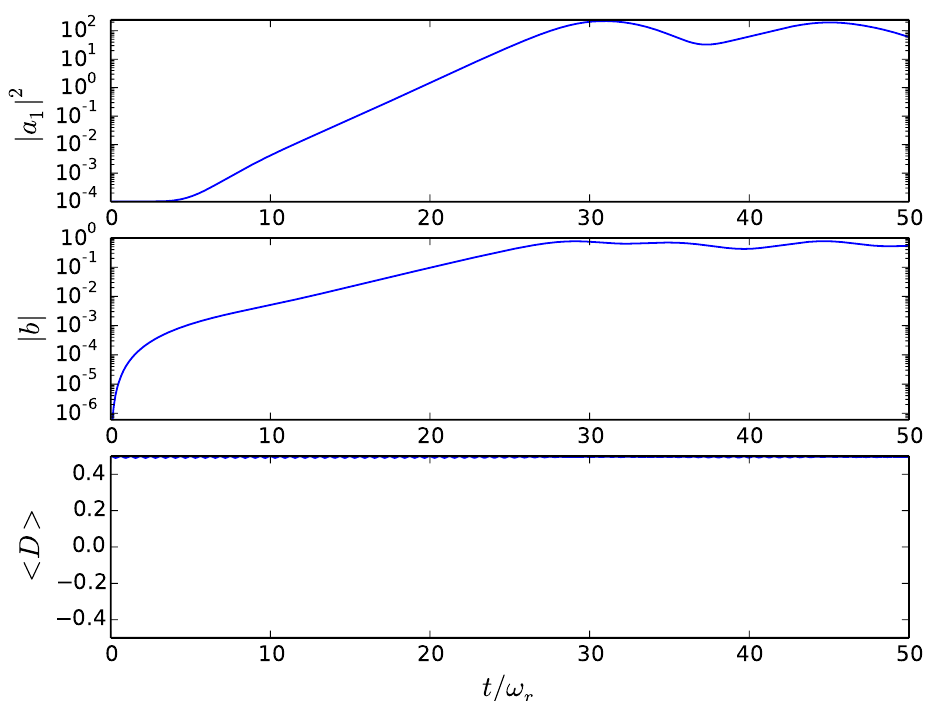
| 2 , bunching parameter, | b | , and mean Figure 3. Evolution of probe photon number, | α 1 population difference, < D > , for a case of weak excitation. The parameters used are U /ω = 5 × 10 − 5 , ∆ = 10 , α = 100 , N = 1000 0 r eg 2